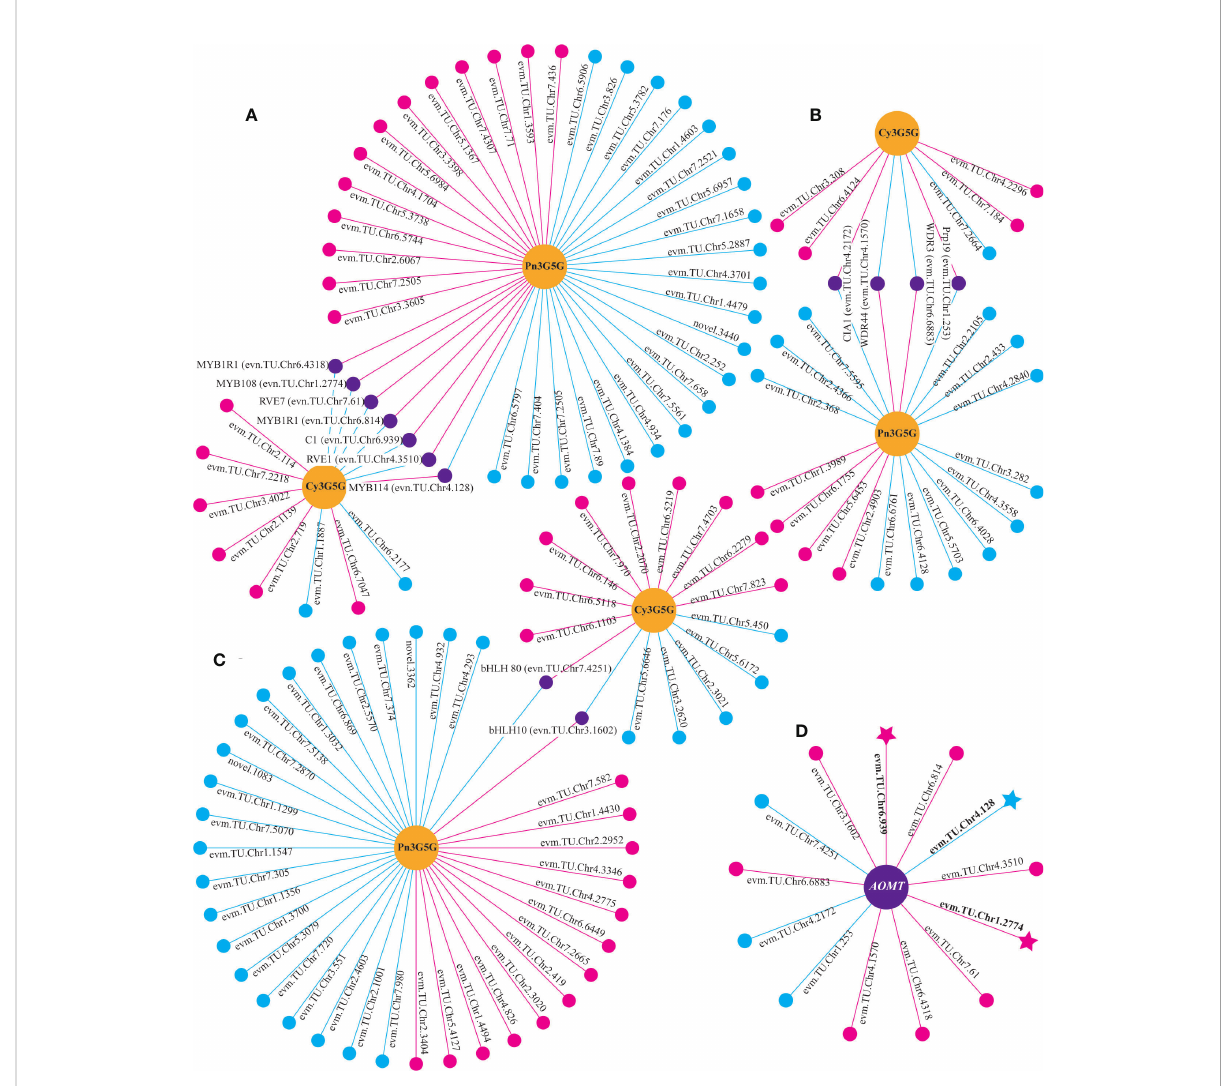
FIGURE 5 Correlation analysis between differentially expressed genes and metabolites. (A) Correlation analysis of between MYB s and two metabolites. (B) Correlation analysis of between WD40 s and two metabolites. (C) Correlation analysis of between bHLH s and two metabolites. (D) Correlation analysis of between TFs and AOMT . Circles colored in “ yellow ” mean metabolites. Circles colored in “ pink ” , “ blue ” , and “ purple ” mean structural genes or TFs. Lines colored in “ pink ” and “ blue ” represent positive and negative correlations,